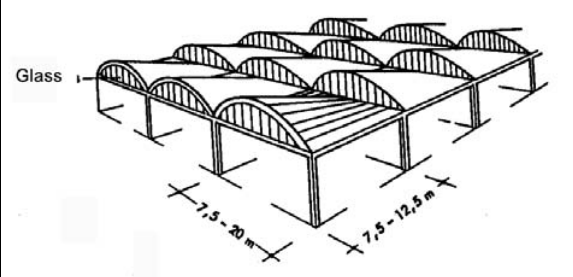
Fig 6. Conical shell with a grader boundary as the tie